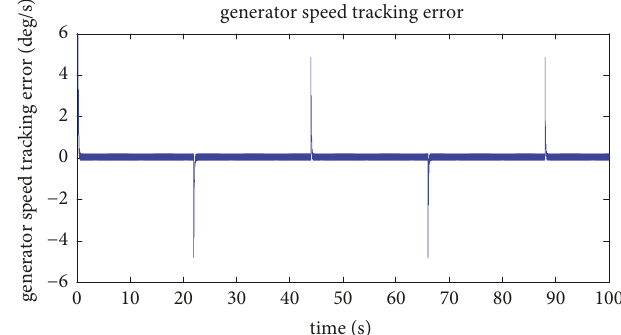
Figure 6: Generator speed tracking error with general VSC.